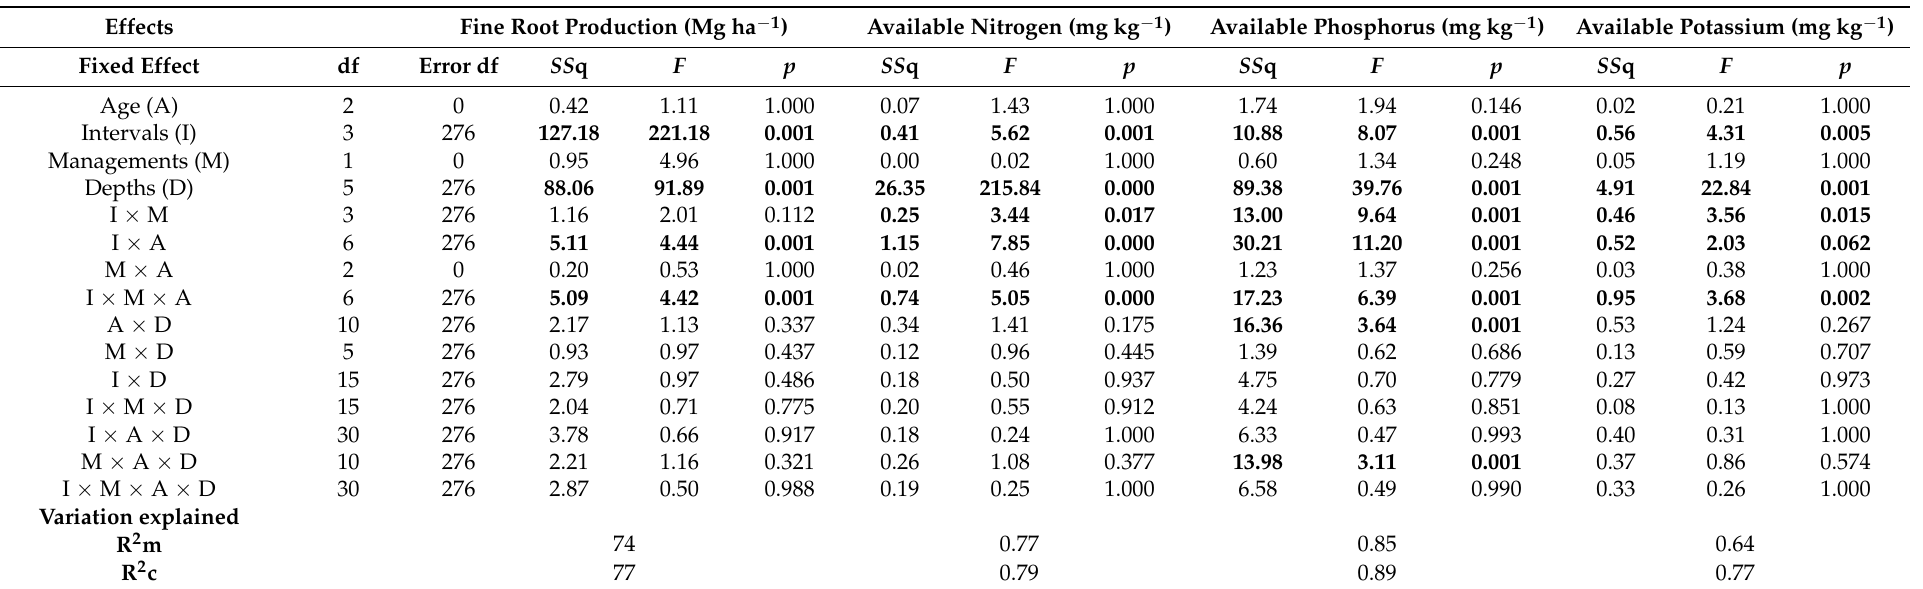
Table 1. Summarized ANOVA for linear mixed effect models testing whether stand age, sampling interval, soil depth, management system (rubber monoculture versus rubber– Flemingia intercropping) or their interactions significantly impact fine root production and available N, P or K. Effects significant at p < 0.05 are